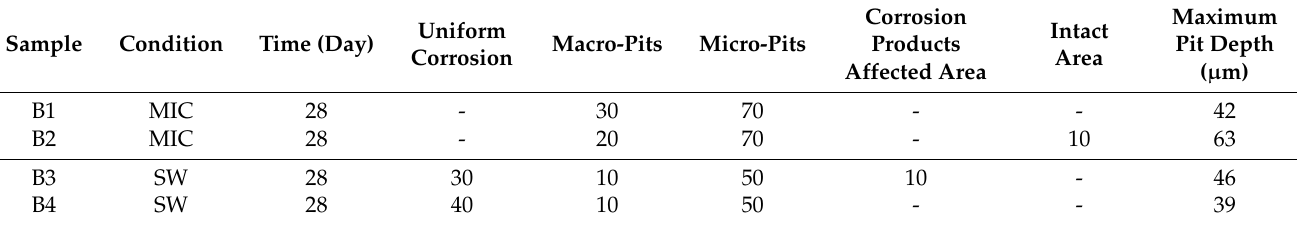
Table 7. Percentage of corrosion area (%) and maximum pit depth of samples B1–B4.